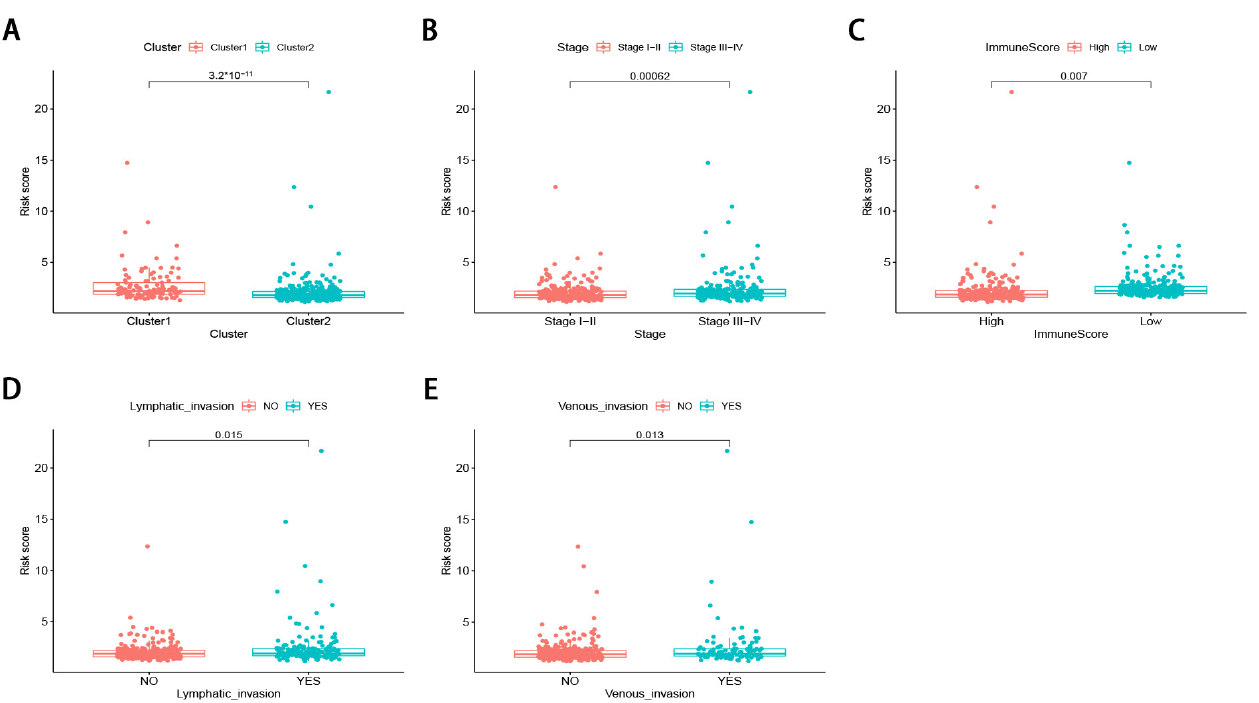
Figure 7. The differences in risk scores by various clinicopathological variables in CRC. ( A ) cluster 1 showed statisti- cally significantly lower risk scores. ( B ) Patients with advanced tumor stage tend to have distinctly higher risk scores. ( C ) patients with high immune score had significantly lower risk scores. ( D , E ) patients with lymphatic and venous invasion had significantly higher risk